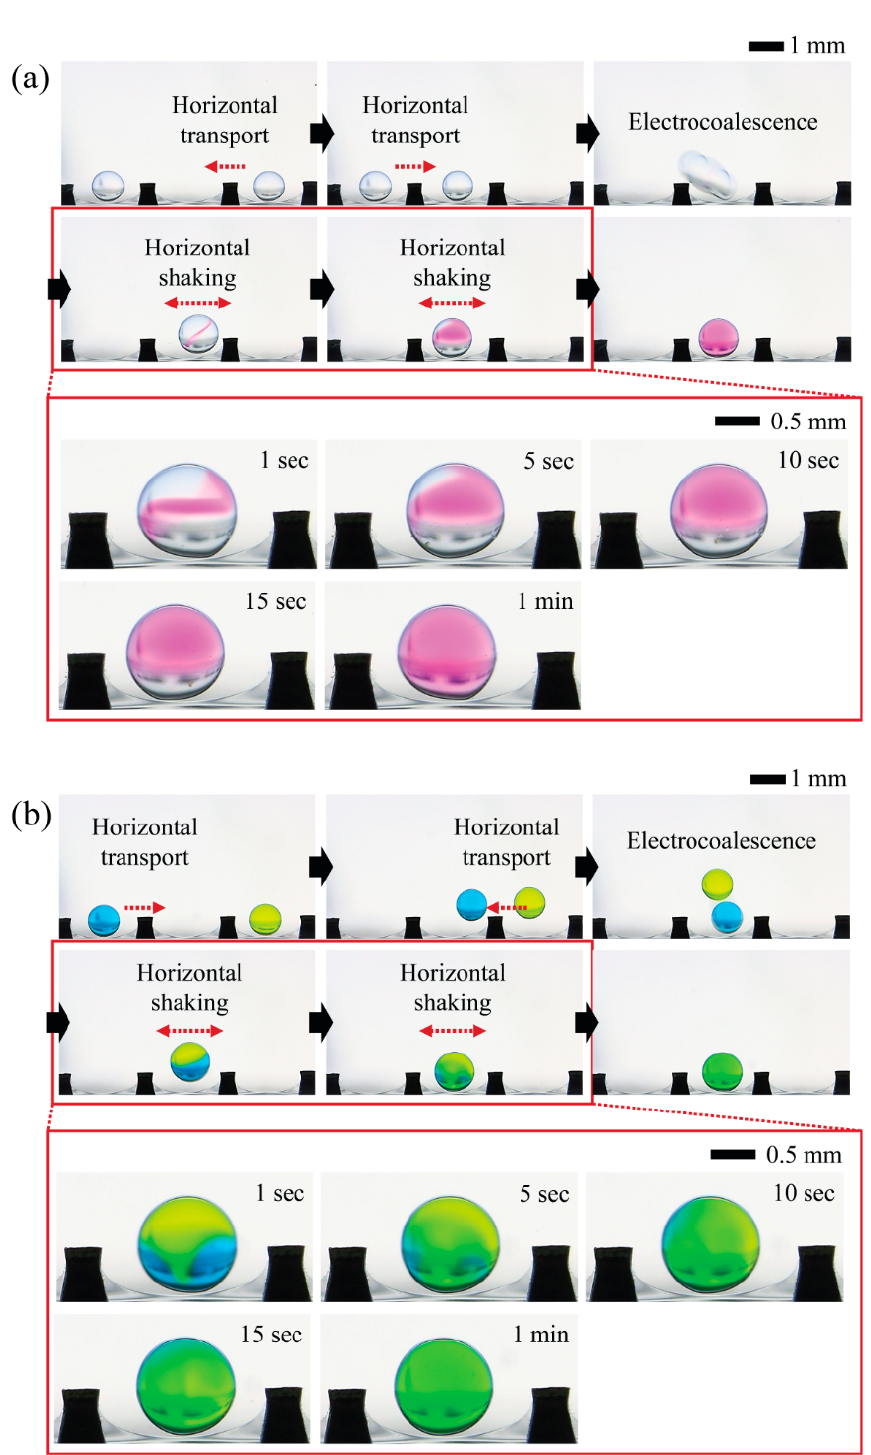
Figure 4. Programmable droplet handling procedure including horizontal transport of two oppositely charged microdroplets containing different chemicals, merging via electrical interaction (i.e., electrocoalescence), and horizontal shaking via horizontal reciprocating motion. ( a ) Mixing between a droplet of PHP indicator solution (left) and a droplet of sodium hydroxide aqueous solution (right) (Video S1 in Supplementary Materials). ( b ) Mixing between a blue dye droplet (left) and a yellow dye droplet (right) (Video S2 in Supplementary Materials). The distance between the pin electrodes is 2 mm in this case, and the applied voltage is 400 V.